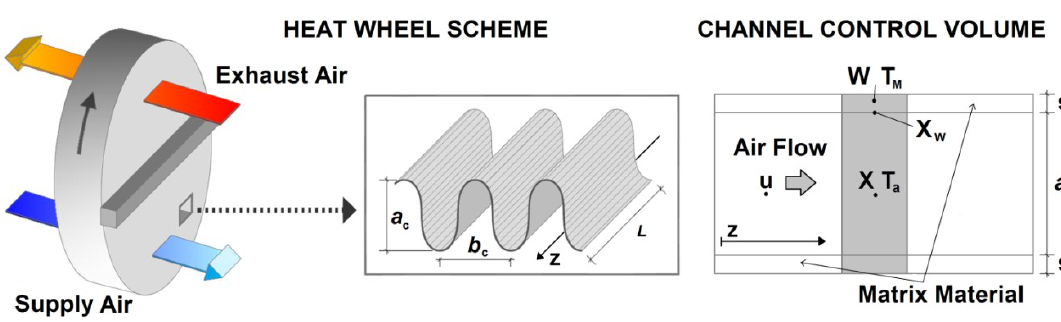
Figure 1. Scheme of heat wheel and channel control